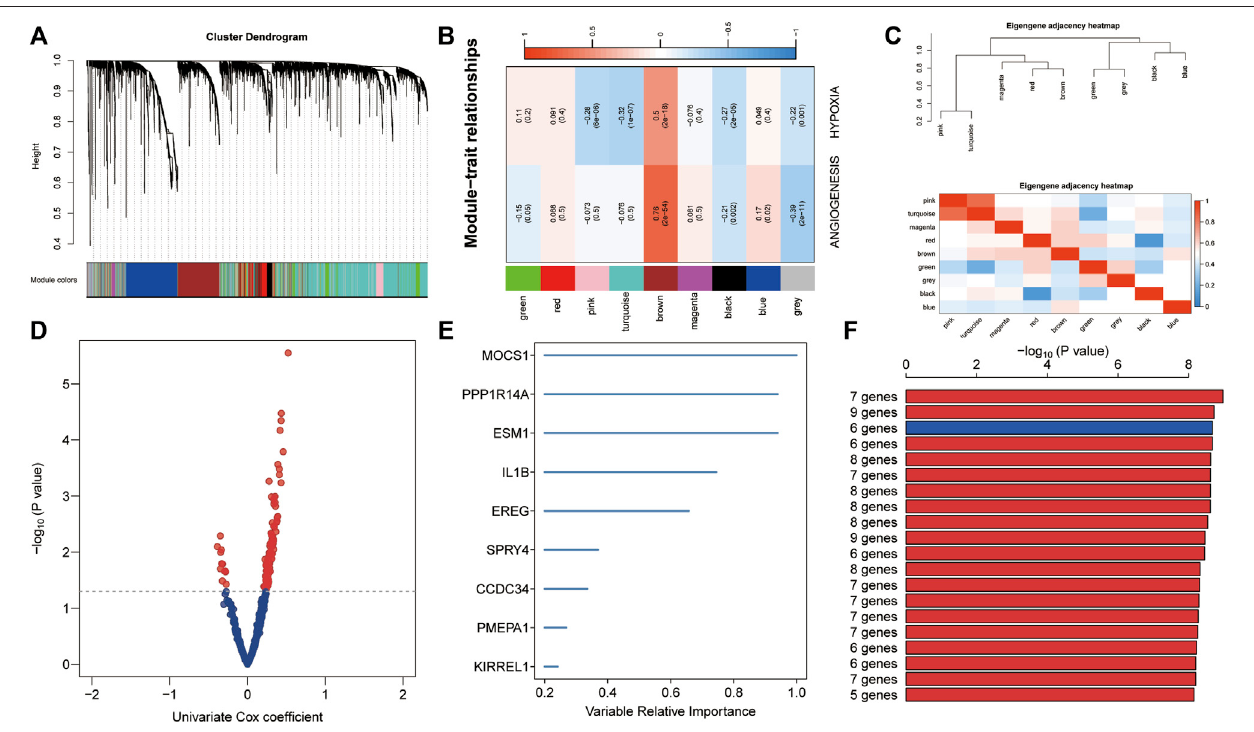
FIGURE 3 | Establishment of hypoxia- and angiogenesis-related gene signatures. (A) Eight non-gray modules were con fi rmed using WGCNA. (B) The brown module was most signi fi cantly related to hypoxia and angiogenesis (r > 0.5, p < 0.0001). (C) Module eigengene adjacency heatmap displaying correlations of co- expressed modules. (D) Key genes from the brown module were screened. Univariate Cox regression was used to identify 109 candidate genes with prognostic potential. (E) Therandomforestsupervisedclassi fi cationalgorithmselected10genesfromthe109candidategenes. (F) Thesix-generiskmodelwasranked fi rstin KM analysis to identify optimal risk